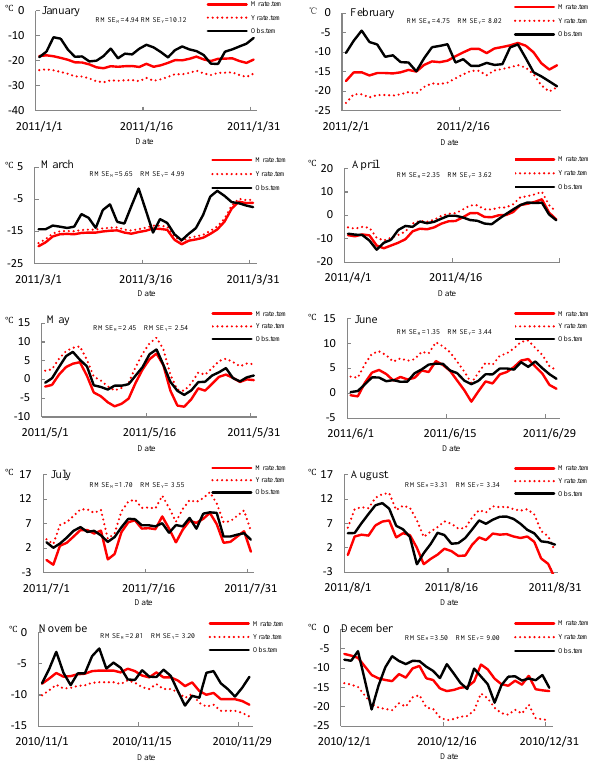
Figure 2. Evaluation of the estimated temperature lapse rate at the BT station. The black solid line is the observed temperature series at BT (Obs.tem); the red solid line is the estimated temperature by monthly lapse rate (Mrate.tem). The red dotted line indicates the es- timated temperature based on annual constant rate (Yrate.tem). The goodness of fit between the observed and estimated temperature is measured by RMSE M for monthly lapse rate and RMSE Y for an- nual constant rate, respectively. The temperature series in Septem- ber and October are absent at BT.